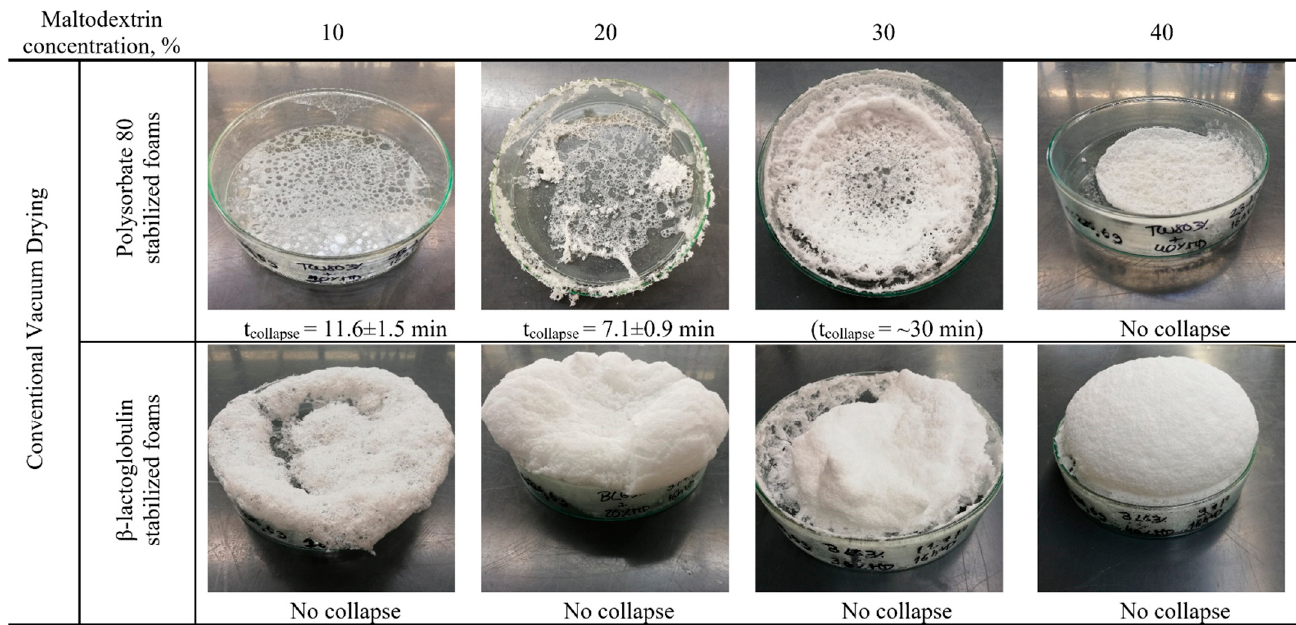
Figure 7. Foam structure after conventional vacuum drying for polysorbate 80 and β -lactoglobulin foam with a maltodextrin concentration between 10% and 40%.